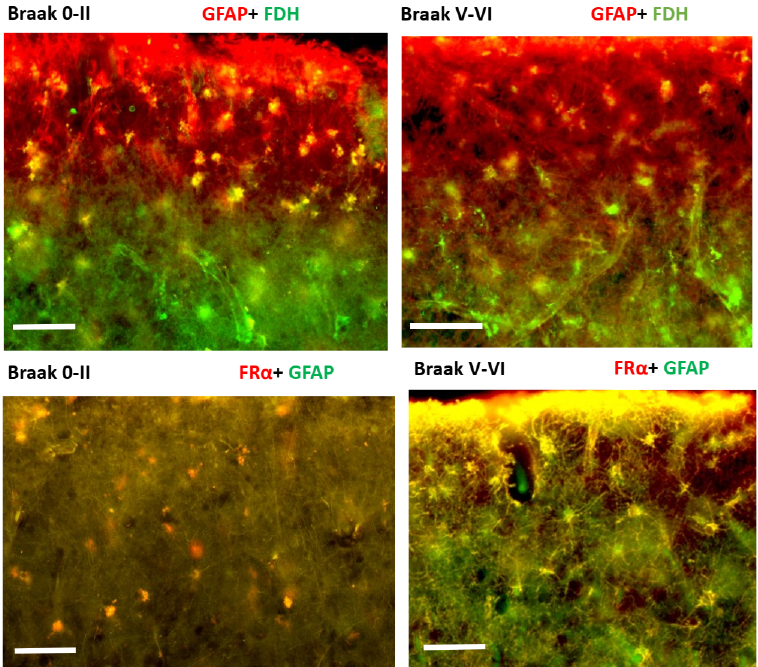
Figure 5. Immunofluorescence staining for GFAP, FR α and FDH. Upper panel: Double immunofluo- rescence staining for FDH (green) and GFAP (red) in normal and AD brains. Co-localisation (yellow) is observed in astrocytes. Lower panel: Double immunofluorescence staining for FR α (red) and GFAP (green) in neurologically normal and AD brains. Co-localisation is observed as bright yellow colour. Magnification 200 × , scale bar: 50 µ m. The figure is representative of neurologically normal n = 3 and AD brains n =